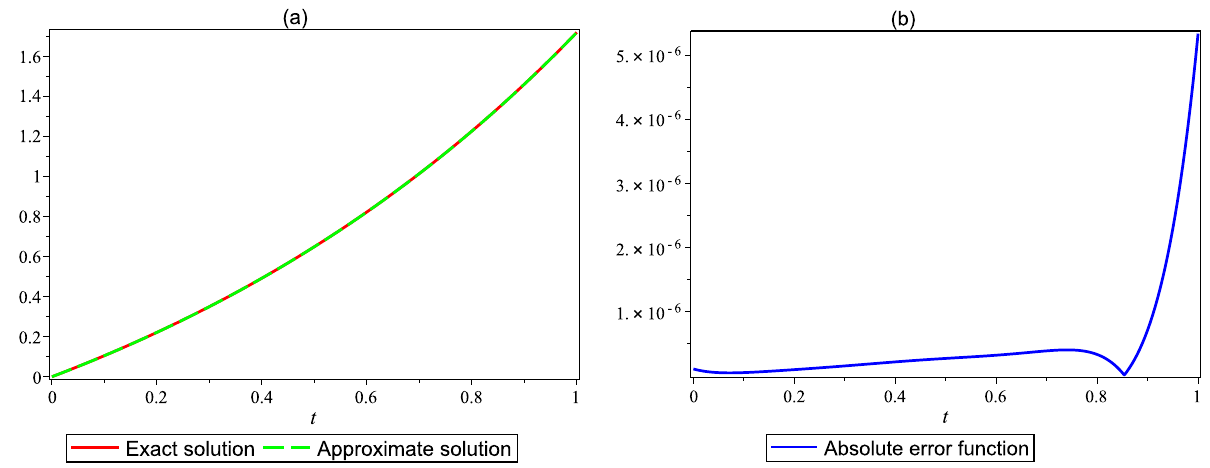
Figure 3. ( a ) Exact and approximate solutions, ( b ) absolute error function for N = 6, η = 1 for Example 2.